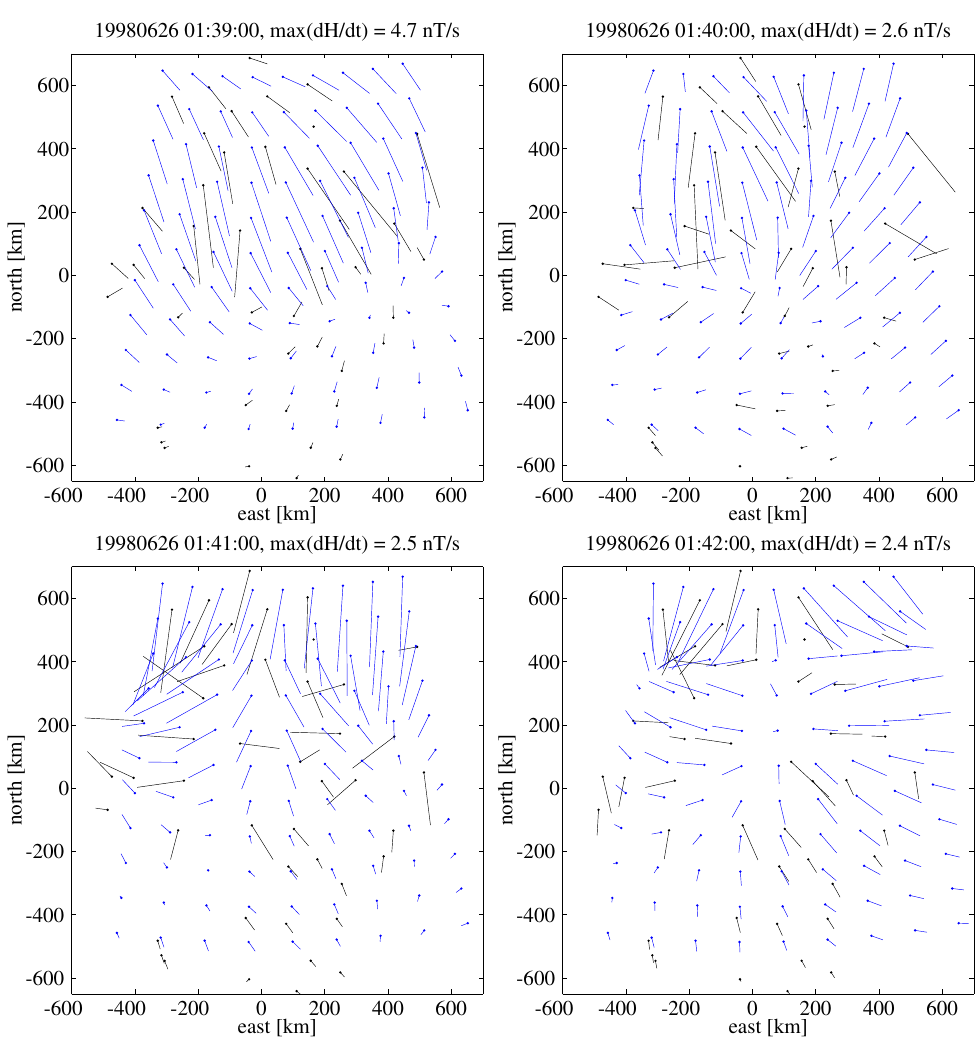
Fig. 4. As Fig. 3, but for time-derivatives of the magnetic field at four consecutive minute intervals in the BEAR region on June 26, 1998.